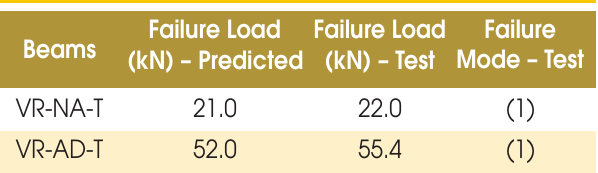
Table 1 – Failure of reference beams